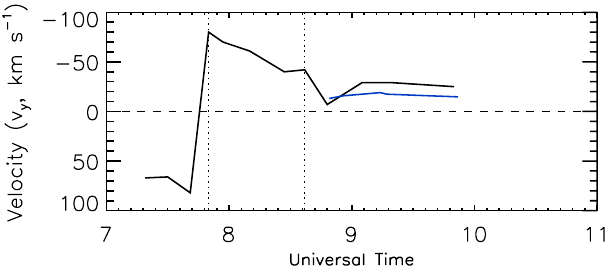
Fig. 13. Plot of current sheet half-thickness against time using the half-thicknesses determined by the Sergeev et al. technique (Clus- ter 1: black, Cluster 4: red) and the Runov et al. technique (blue).